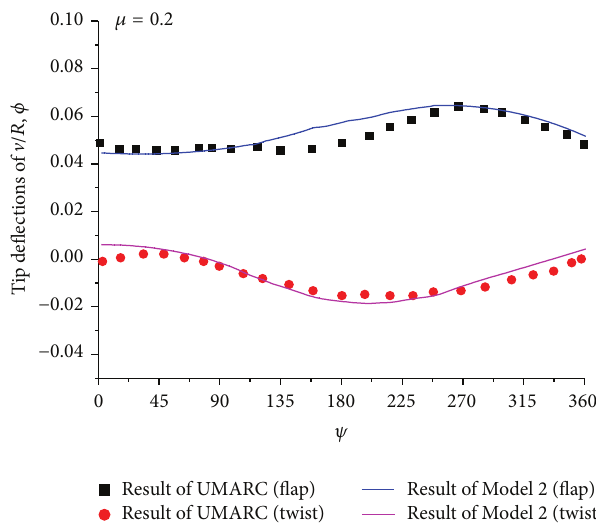
Figure 8: Comparisons of the blade tip deflections.